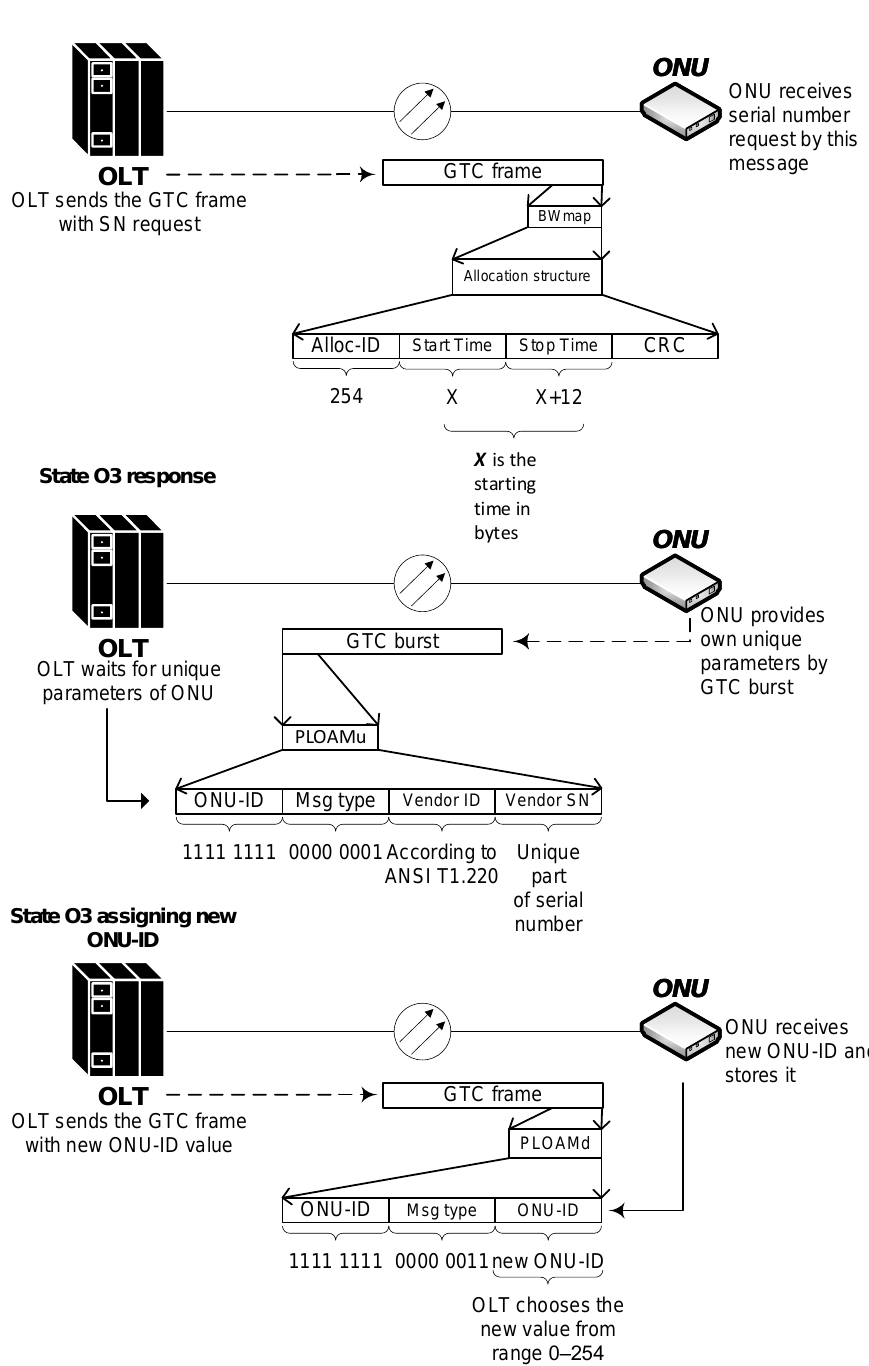
Figure 9. Activation process of ONU in a GPON network with PLOAM message details for state